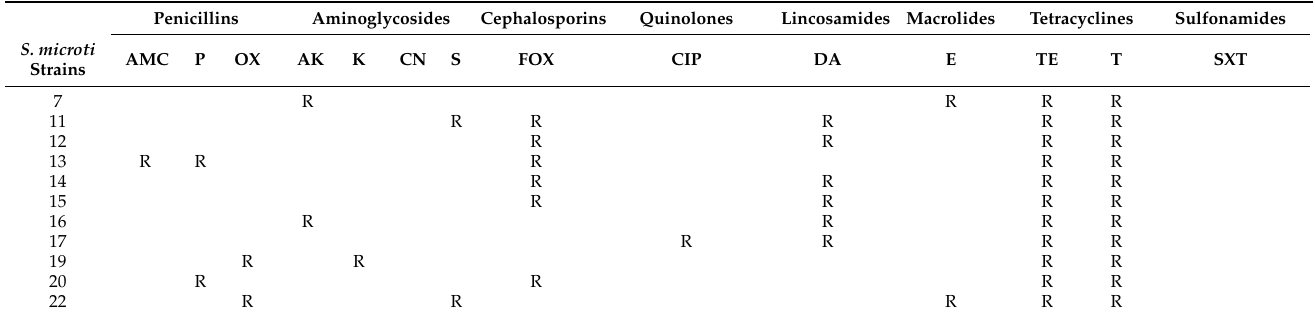
Table 6. Antibiotic resistance profiles of 11 multidrug-resistant S. microti